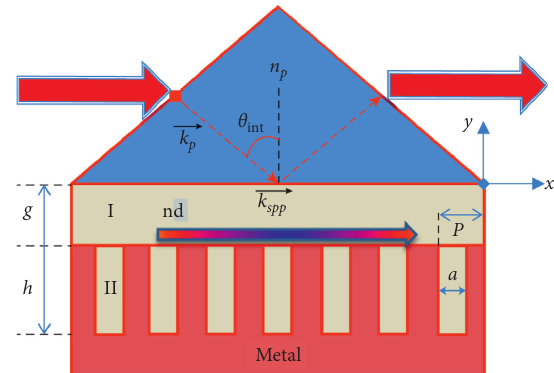
Figure 1: The Otto sensing configuration of the SSPPs excitation in the attenuated total reflection regime using a high-permittivity prism and a periodic metal grating. The width, depth, and period of the groove are a , h , and P , respectively. The gap distance between the prism base and the surface of the metal grating is g ; k is the SPP wave vector of the SSPPs wave. θ is the internal incident angle at int the bottom of the prism. The SPR reflectivity is close to zero, and the off-SPR reflectivity is close to